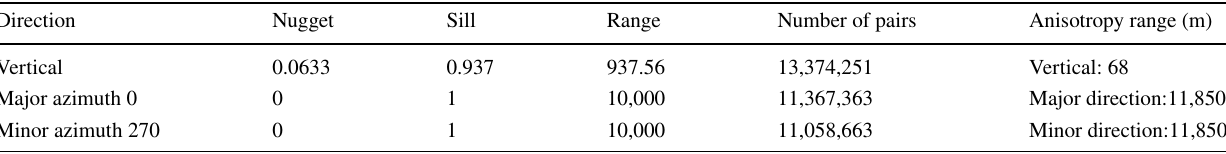
Table 8 Results of Gaussian variogram of the pore pressure cube obtained by combining SGS and co-kriging methods with acoustic impedance (AI), and FFBP-NN methods in the study